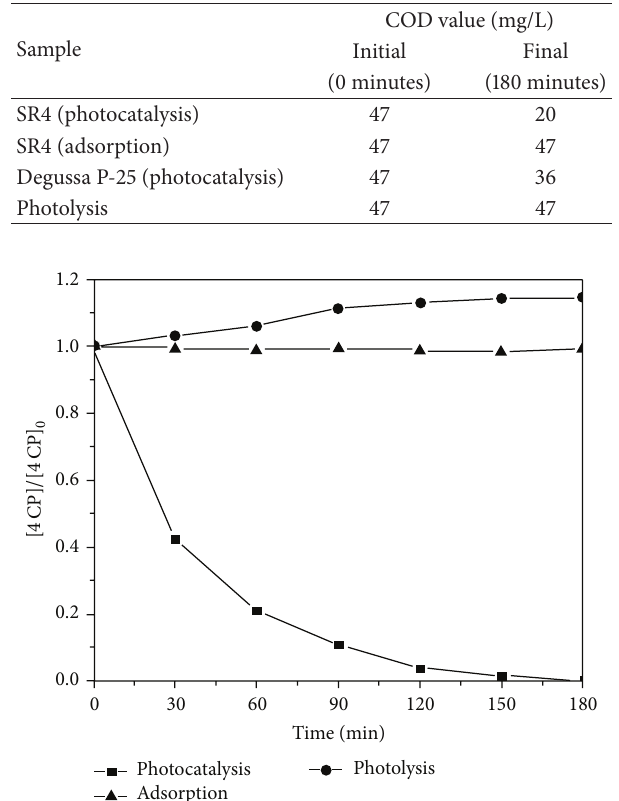
Table 5: COD values of the aqueous solution before and after photocatalytic tests, adsorption, and photolysis.